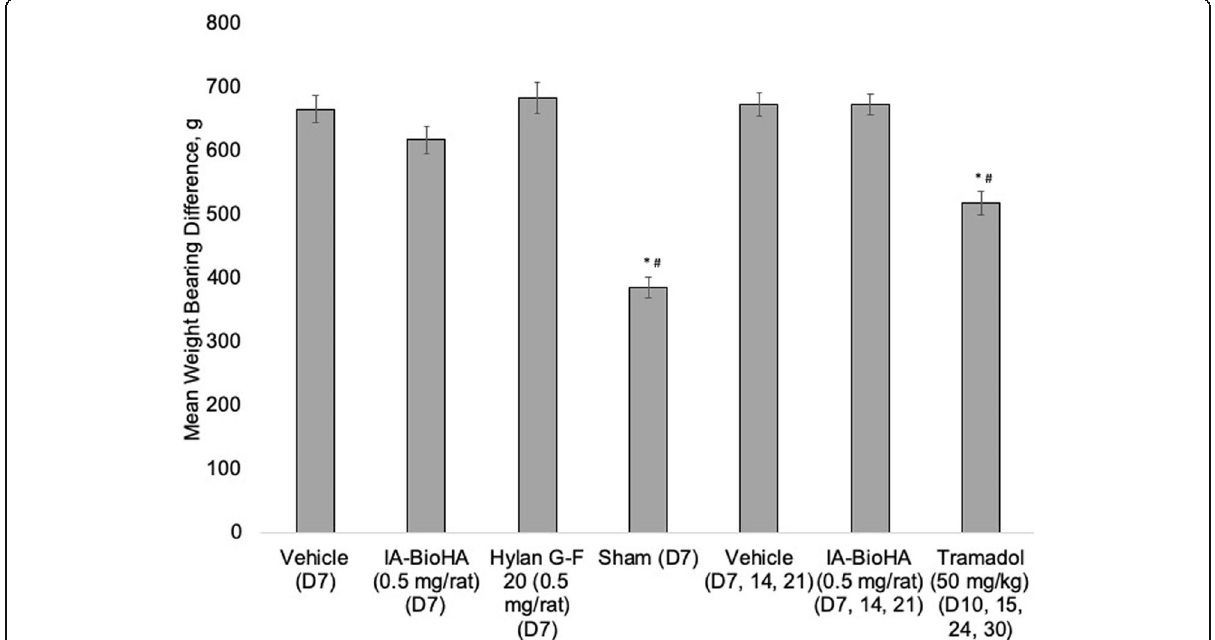
Fig. 7 Incapacitance testing: weight bearing differential (left-right). Results shown are area under the curve. Error bars represent 1 standard error from the mean. n = 15 rats/group for test article and vehicle control, n = 10 rats/group for sham surgery and tramadol groups. * p = 0.001 Student ’ s t -test vs. vehicle (PBS) D7. # p = 0.001 Student ’ s t -test vs. vehicle (PBS) D7, 14,